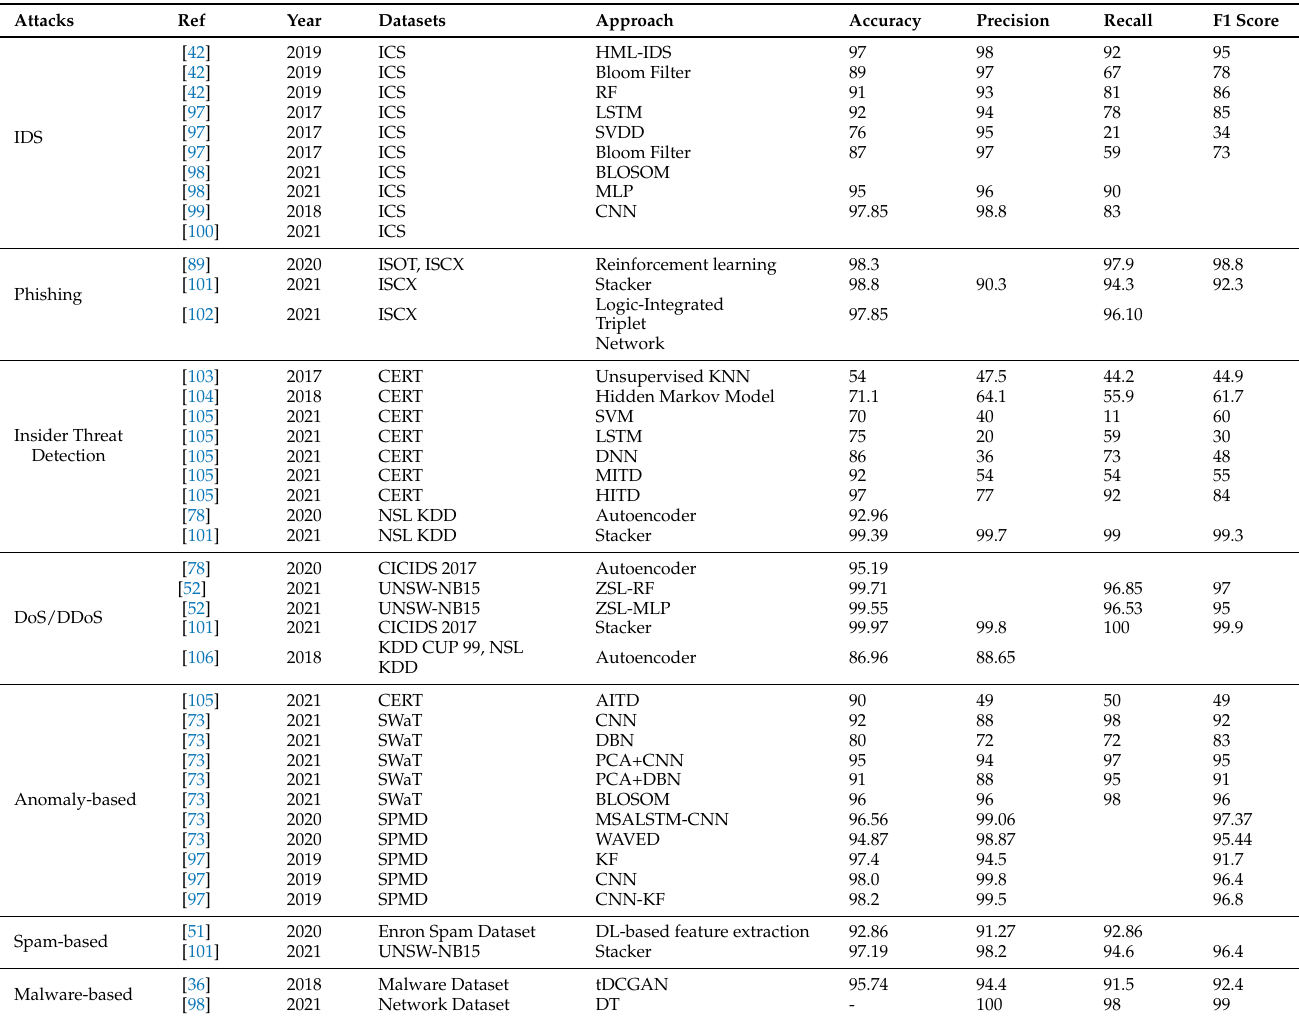
Table 3. A comparison of different AI-based techniques for zero-day attack